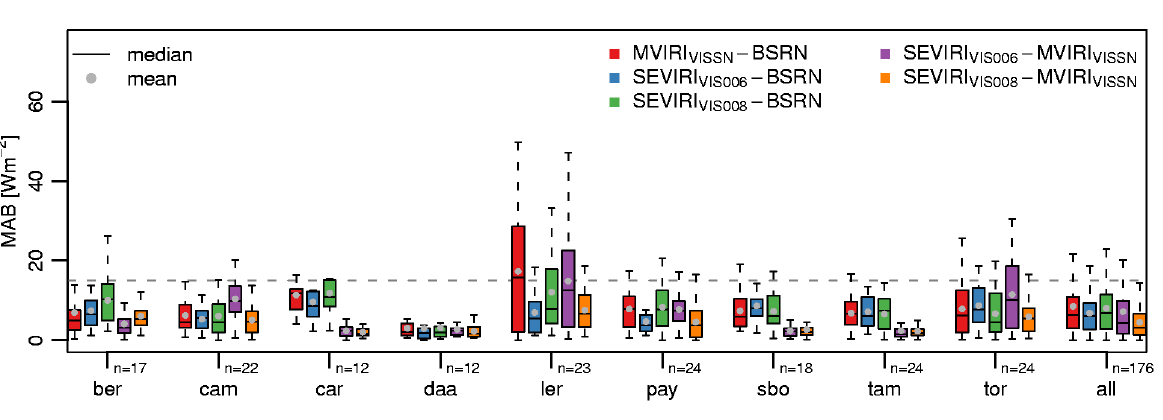
Figure 3. Bias and MAB for the comparison of satellite retrieved SIS versus BSRN measurements of all relevant BSRN stations and for first and second generation satellites.